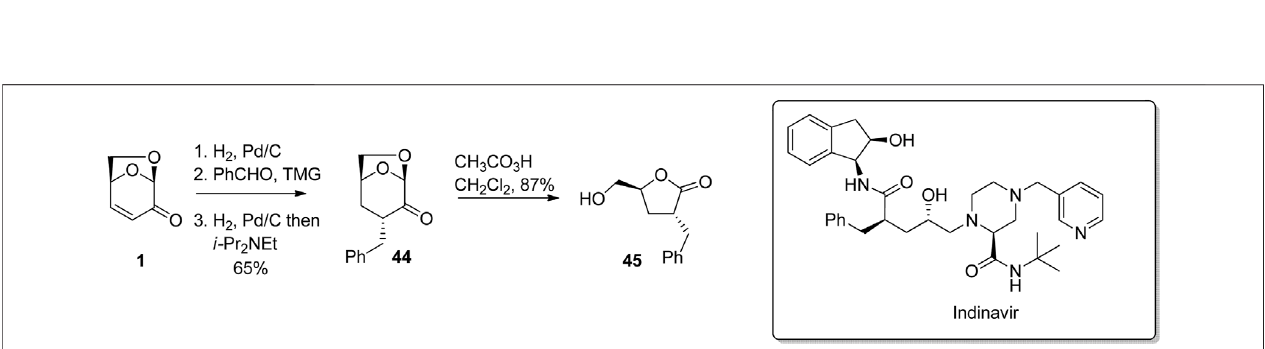
FIGURE 14 | Preparation of a key intermediate that can be used in the preparation of